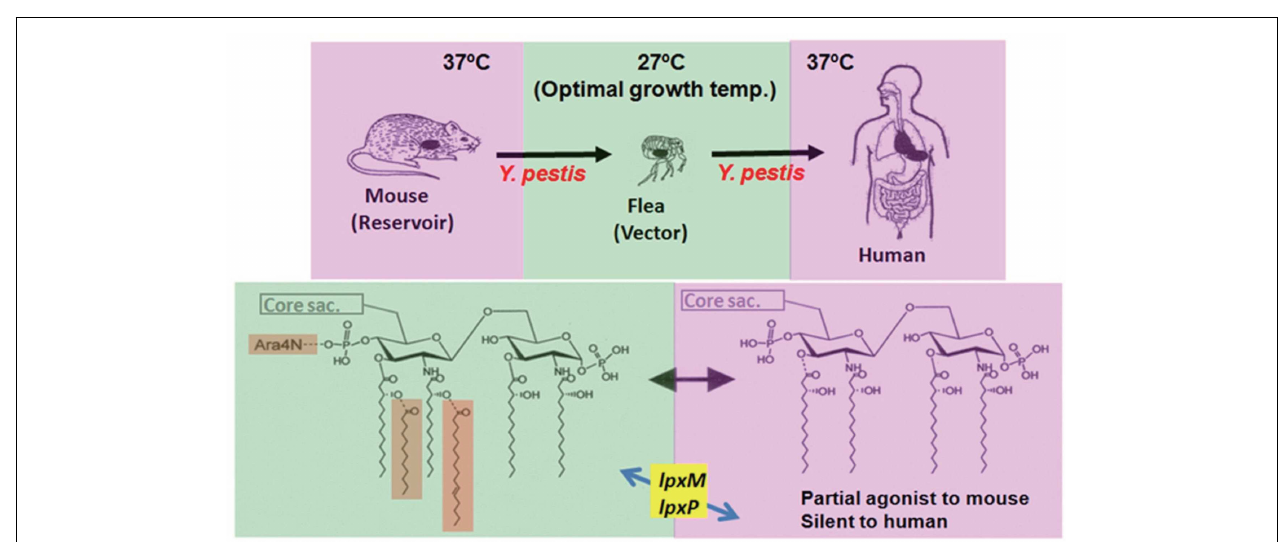
temperature. At this temperature, expression of the late acyltransferase genes ( lpxM and lpxP ) is upregulated, and a hexa-acylated type becomes predominant among its lipid A species.Then, the bacterium moves into a human body through the bite of an infected flea and grows at 37˚C. At this temperature, the expression of the late acyltransferase genes is downregulated, and the major lipid A species shift to the tetra-acylated type. Y. pestis containing such lipid A species is not sensed (is silent) by the humanTLR4-mediated innate immune system, and the bacteria can grow freely and induce severe